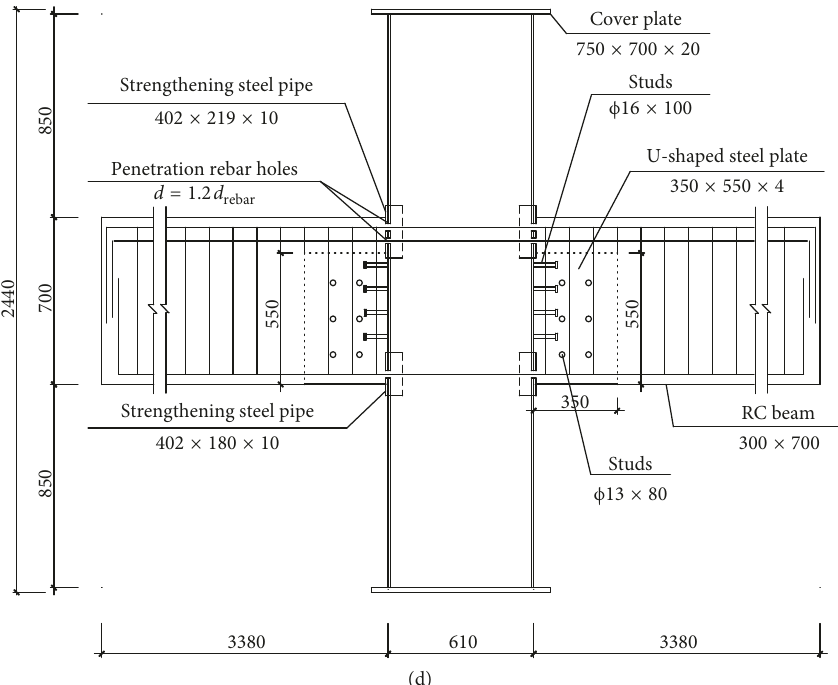
Figure 3: Sizes and connection configurations for specimens SSJD and SUJD: (a) schematic diagram of SSJD and SUJD; beam-column connections of (b) left: SSJD and right: SUJD; sectional views of (c) SSJD and (d)